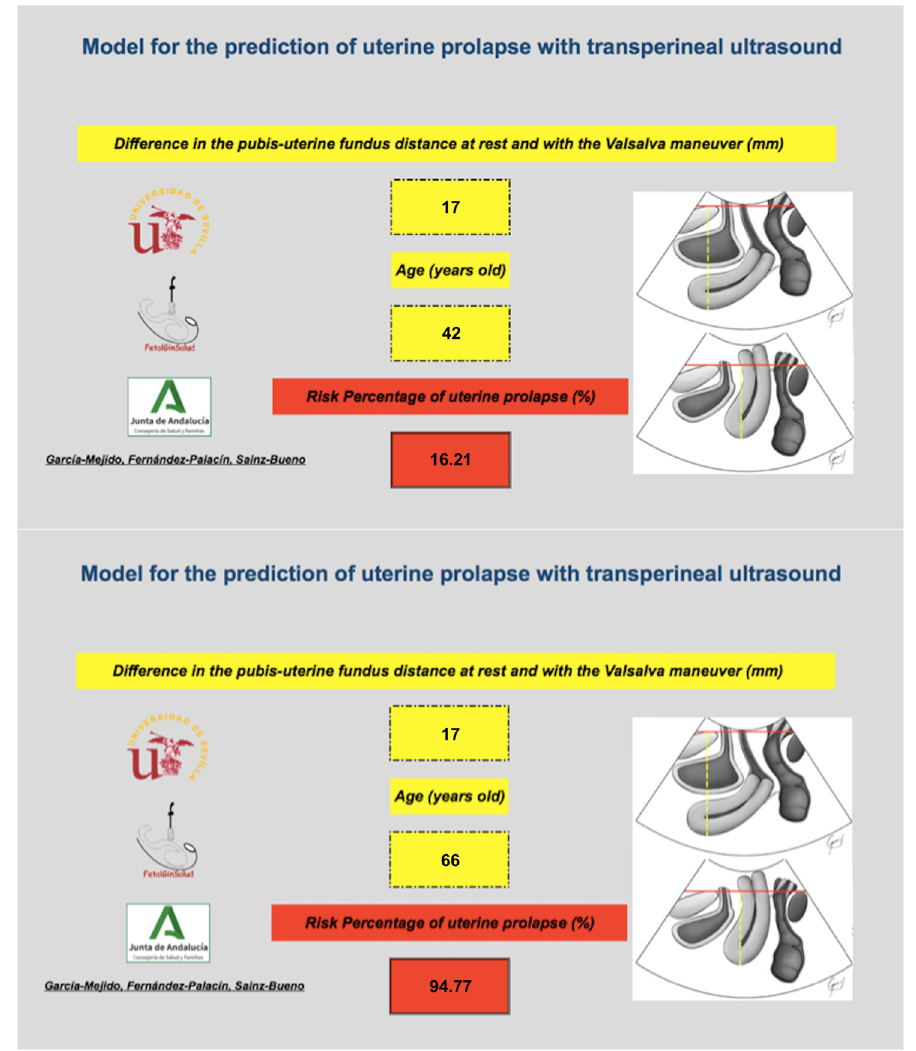
Figure 4. Example of the use of the binary model based on the difference in the pubis–uterine fundus distance at rest and with the Valsalva maneuver and age as a predictor of UP. The image above shows how a 42-year-old patient with a difference in the pubis–uterine fundus distance at rest and with the Valsalva maneuver of 17 mm has a personalized risk of having a PU of 16.2%. The lower image shows how a 66-year-old patient with a difference in the pubis–uterine fundus distance at rest and with the Valsalva maneuver of 17 mm has a personalized risk of having a PU of 94.8%.